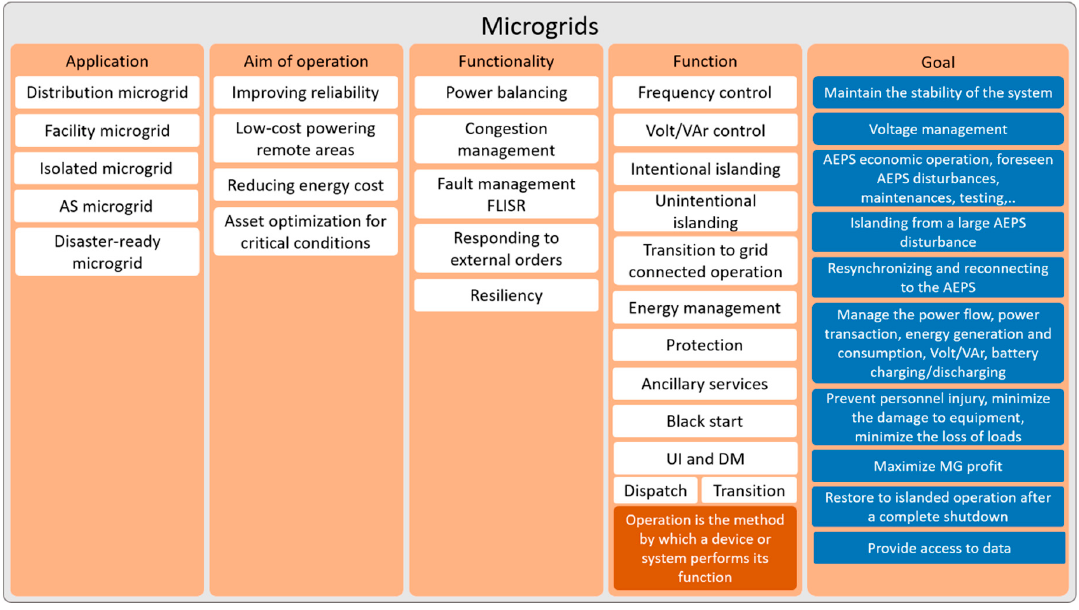
Figure 3. The functional analysis of microgrids.